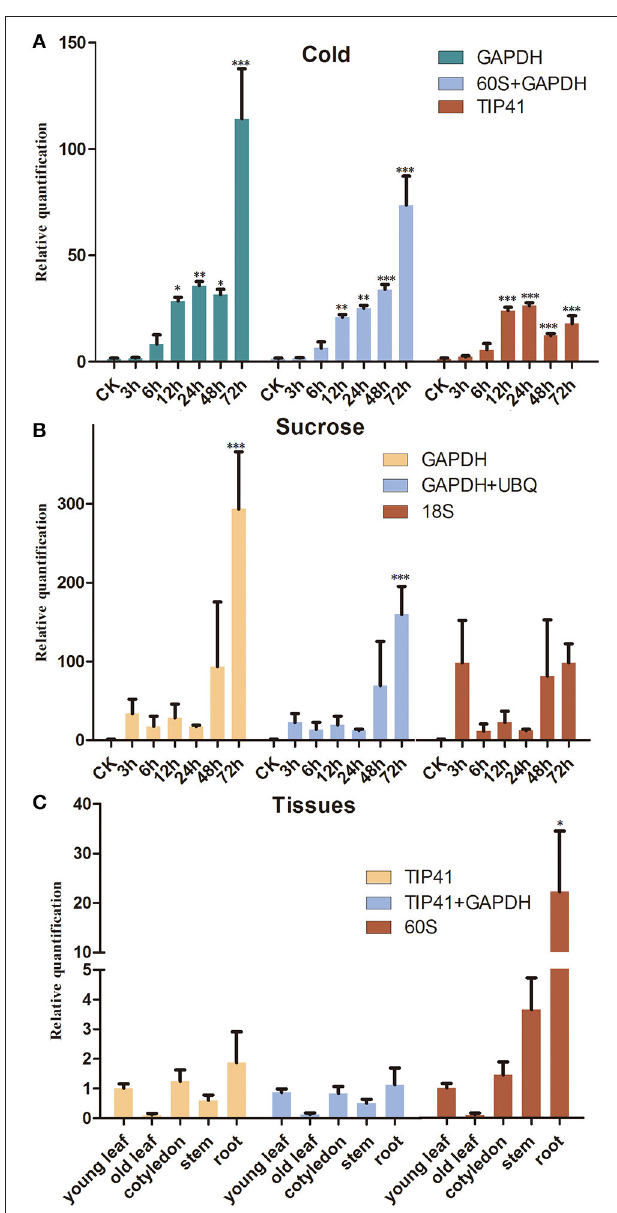
FIGURE 3 | Relative quantification of SsCHS expression using the validated reference gene(s). (A) Leaves were collected from 3-week-old seedlings subjected to cold-stress after 0, 3, 6, 12, 24, 48, and 72h of treatment. (B) Leaves were collected from 3-week-old seedlings subjected to sucrose-stress after 0, 3, 6, 12, 24, 48, and 72h of treatment. (C) Different tissues were collected from 3-week-old seedlings. * indicates statistically significant ( p < 0.05); **Indicates greatly statistically significant ( p < 0.01); ***Indicates greatly statistically significant ( p < 0.001). The results are depicted as the mean ± SD ( n =